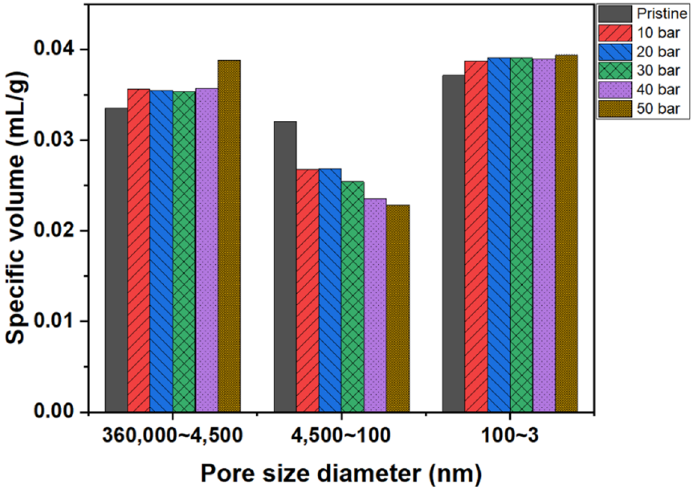
Figure 7. Pore size distributions of graphite blocks before and after impregnation at various pressures.